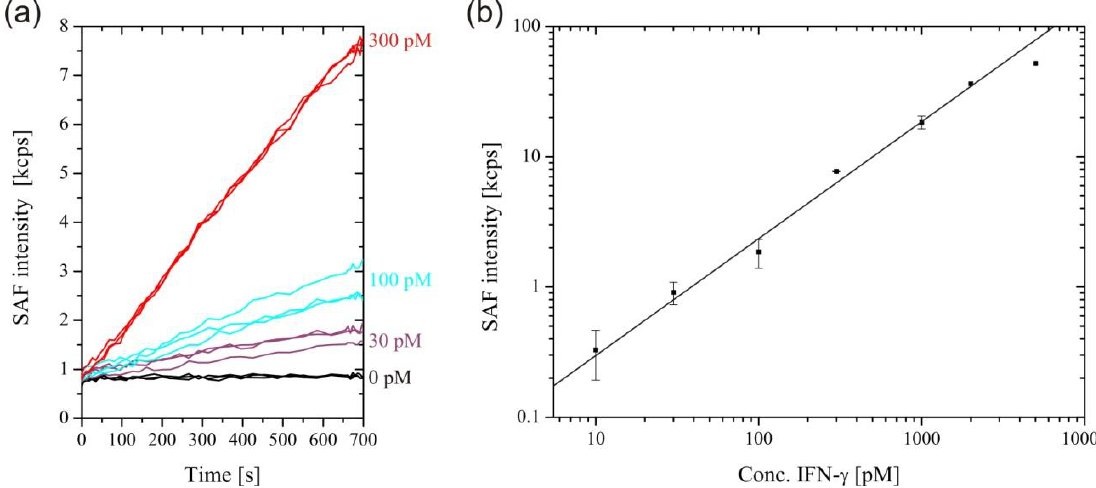
Figure 3. ( a ) Real-time measurement of selected concentrations of Interferon-γ (IFN-γ) . ( b ) SAF intensity increase after 700 s plotted against IFN-γ concentration. A straight line through the origin was fitted to the data for IFN-γ concentrations up to 2 nM (Adjusted R-squared = 0.995). The linear relationship is lost at higher concentrations due to depletion of the free detection